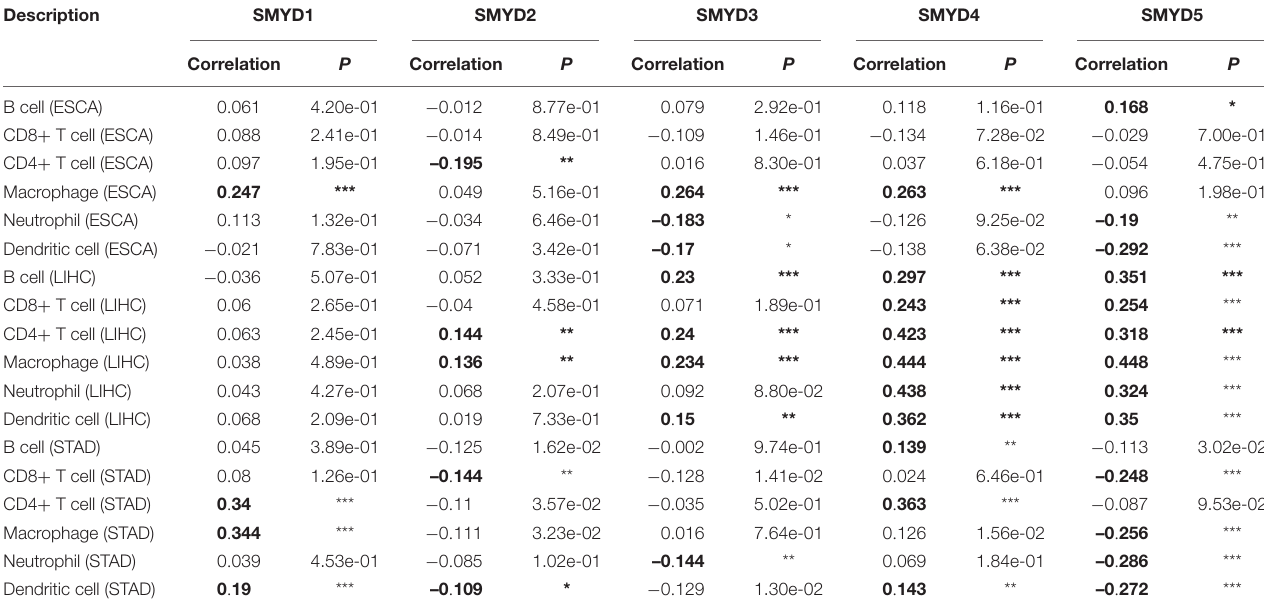
TABLE 4 | Correlation between SMYD members and ESCA, LIHC, and STAD immune cell infiltration (TIMER).